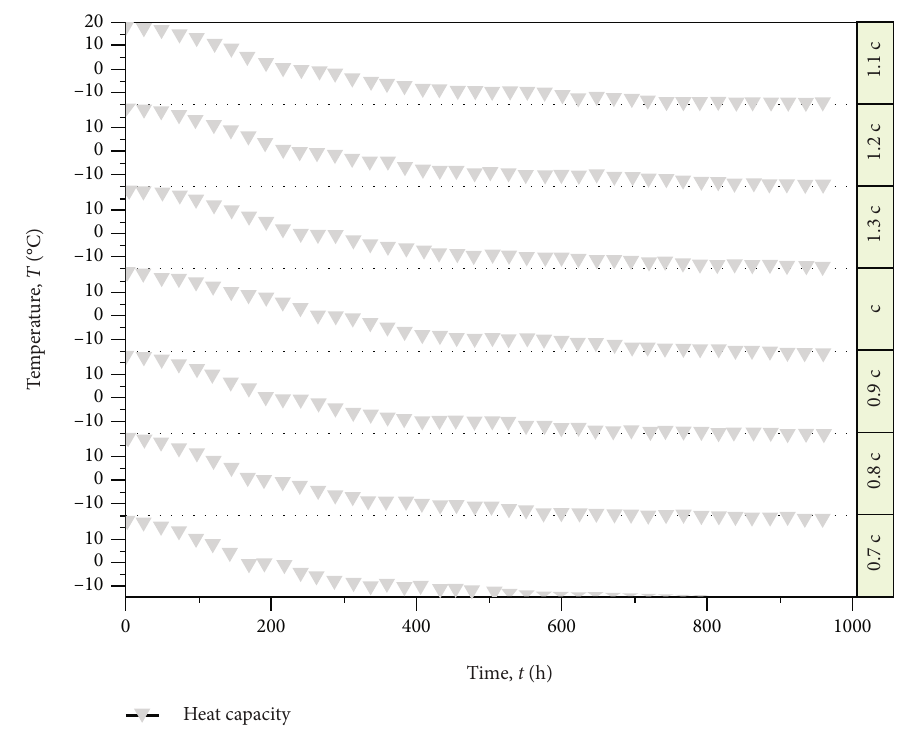
Figure 9: E ff ect of heat capacity on temperature fi eld development.